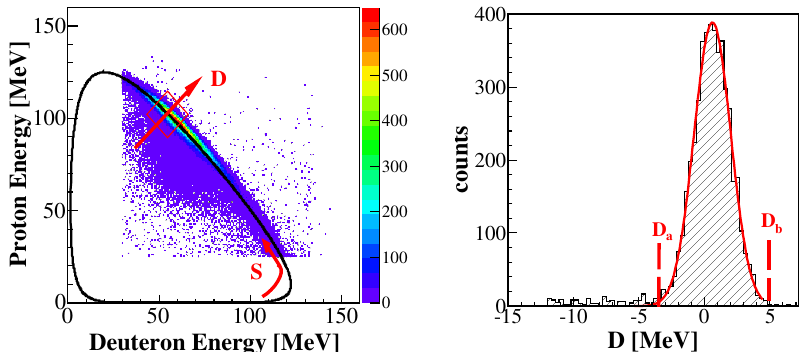
vs . E coincidence spectrum of the proton- p d = 24 ◦ ± 1 ◦ , θ = 28 ◦ ± 1 ◦ , ϕ = 180 ◦ ± 5 ◦ . The solid d p dp and D , a b